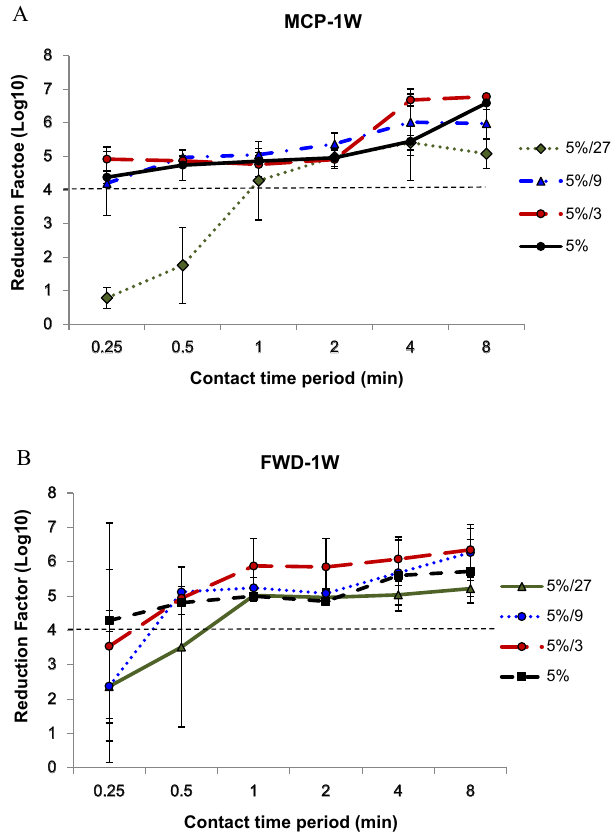
Figure 2. Virucidal activity of undiluted and diluted MCP ( A ) and FWD ( B ) kept for one week at ambient temperature against Nipah virus (MCP-1W and FWD-1W). The biocide concentrations ranged from ~ 5% to 0.19% (5% to 5%/27, using a three-fold serial dilution scheme) with conatct times of 15 s to 8 min. The residual infectivity was determined by virus titer using one-step real-time